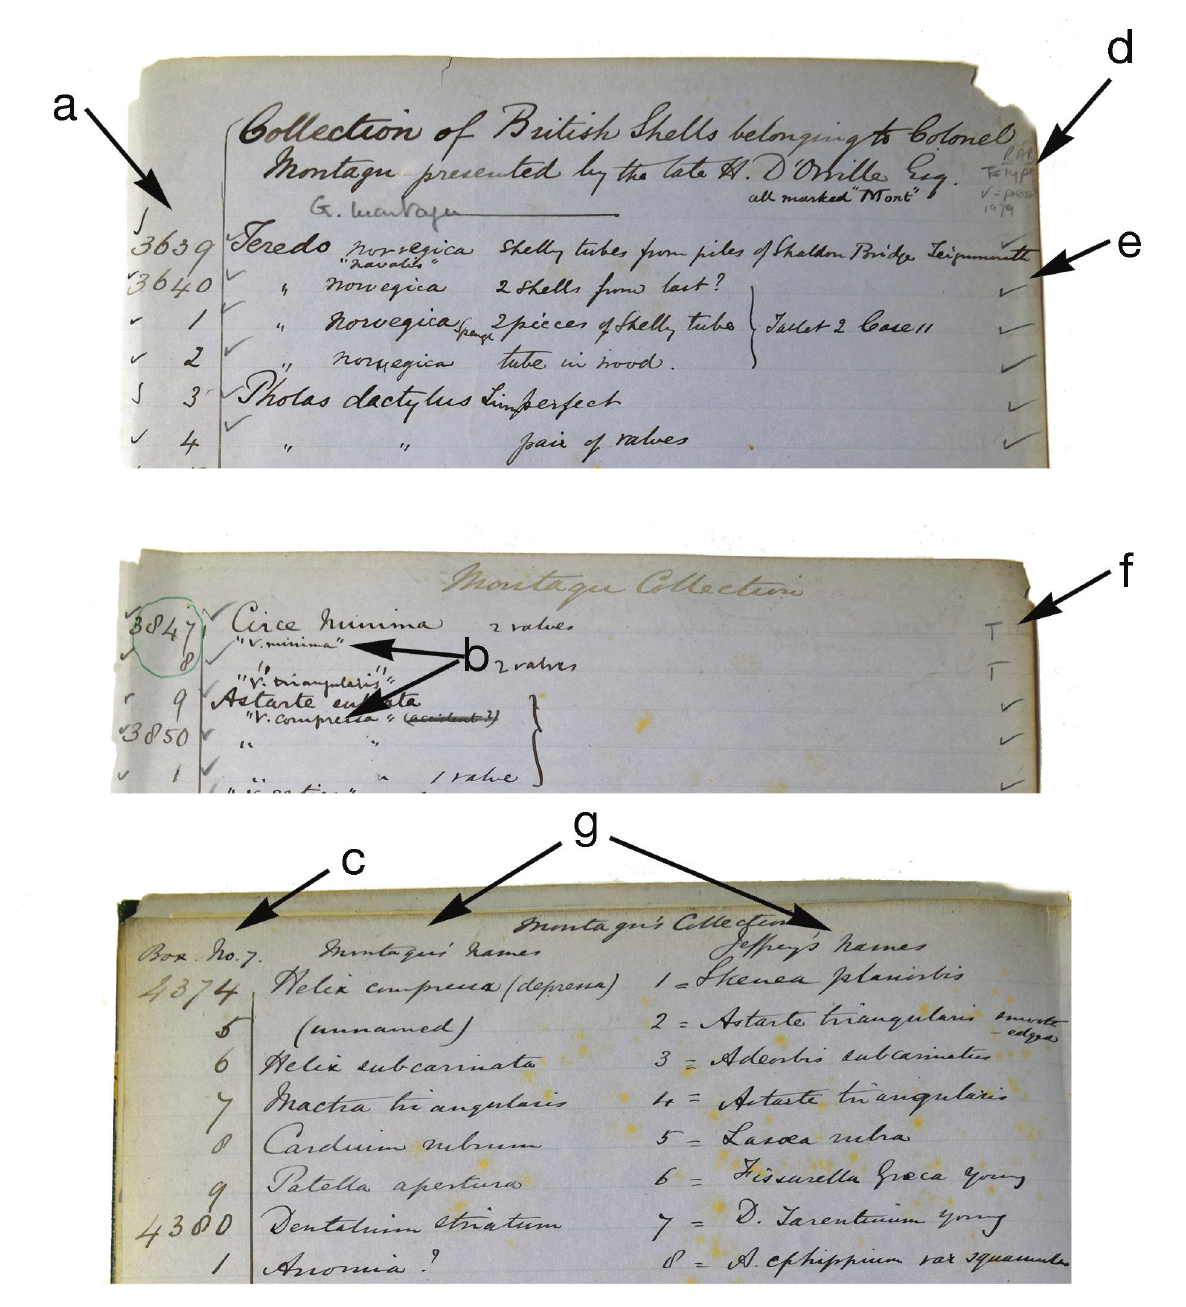
Figure I2. Extracts from the original register of the Montagu collection in RAMM, Exeter. a numbering sequence starting at 3639 b double entries, the lower giving the original Montagu name. c beginning of the “box numbers” of material no longer present. d pen- cil annotation identifying actions of Rosemary Brind, 1979. e pencil tick marks indicating lot found in 1979. f “T” mark indicating type status as recognised by Brind (1979) g dual naming of lots contained in boxes but no longer